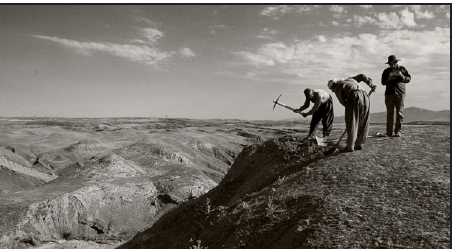
Figure 2: Fieldwork at Jarmo, Iraqi Kurdistan (Photo Charlene